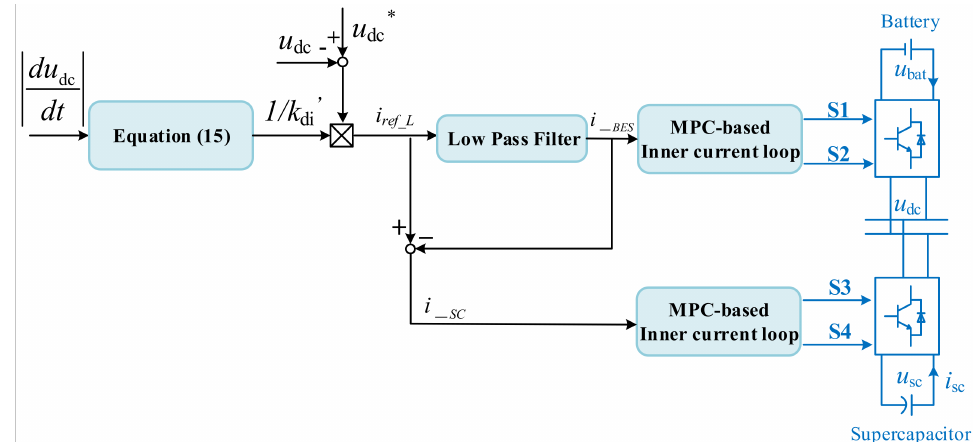
Figure 11. Control architecture for proposed AIC in Reference